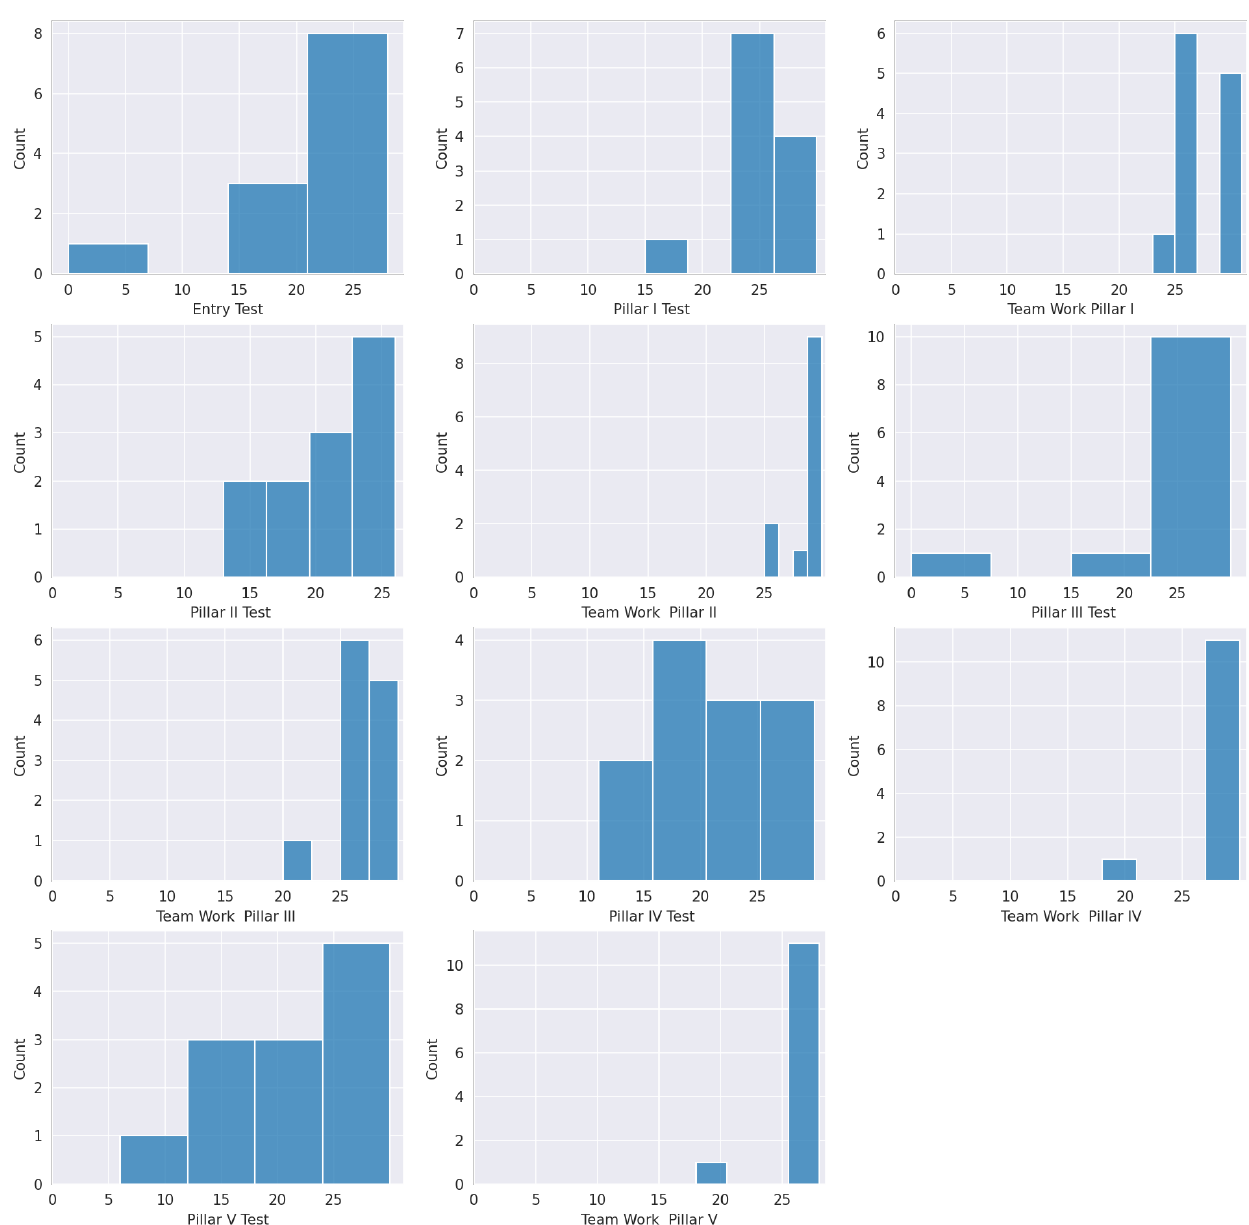
Figure 1. The distribution of the students’ marks for the academic year